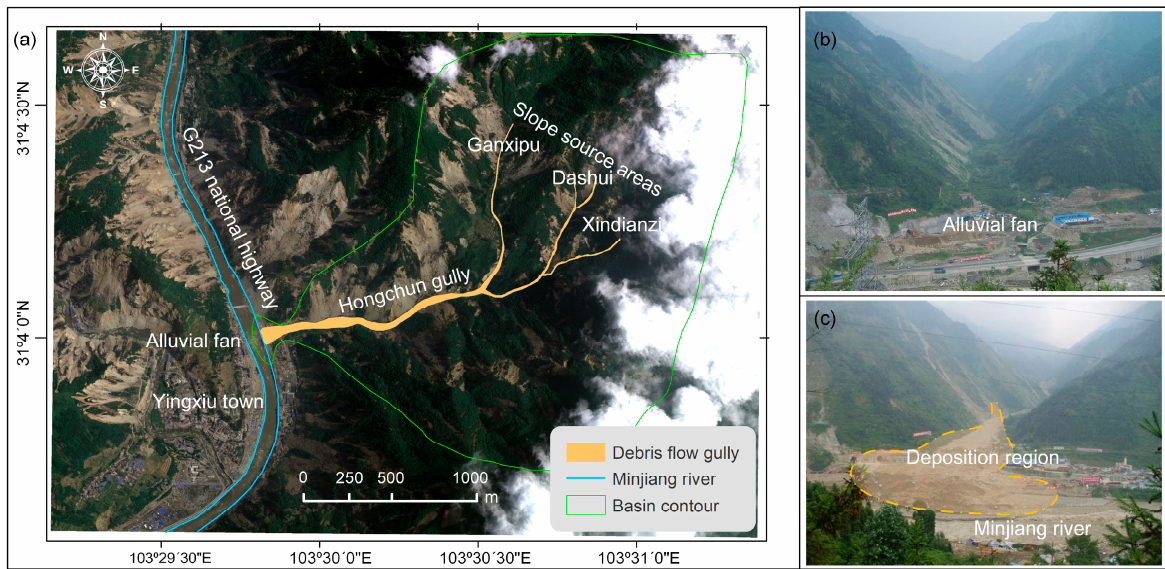
Figure 6. Overview of the 14 August 2010 debris-flow event in Hongchun catchment, Yingxiu town, Sichuan province, China. ( a ) Overview of the 2010 debris-flow event. ( b ) The alluvial fan before the event. ( c ) The alluvial fan after the event.